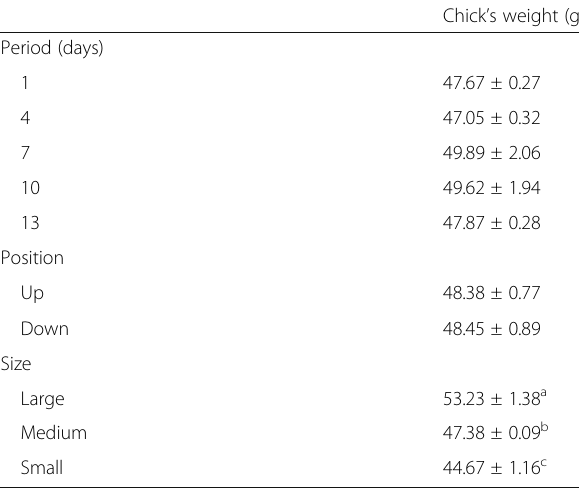
Table 4 Effects of the interaction between storage period and position, storage period and egg size, and egg size and